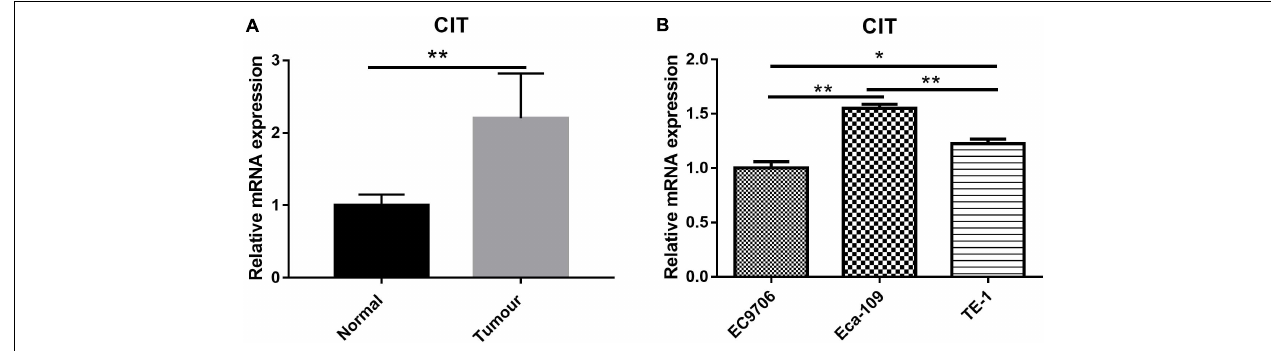
FIGURE 1 | Expression of CIT in ESCC tissues and cell lines. (A) The gene expression profile of CIT in ESCC tissues and adjacent normal tissues based on microarray data GSE20347. Expression of CIT is significantly higher in ESCC tissues than that in normal tissues adjacent to tumor tissues. (B) The level of CIT mRNA in ESCC cell lines (EC9706, Eca-109, and TE-1) was identified by qRT-PCR and analyzed by 2 − (cid:49)(cid:49) CT method. * P < 0.05 and ** P < 0.01.